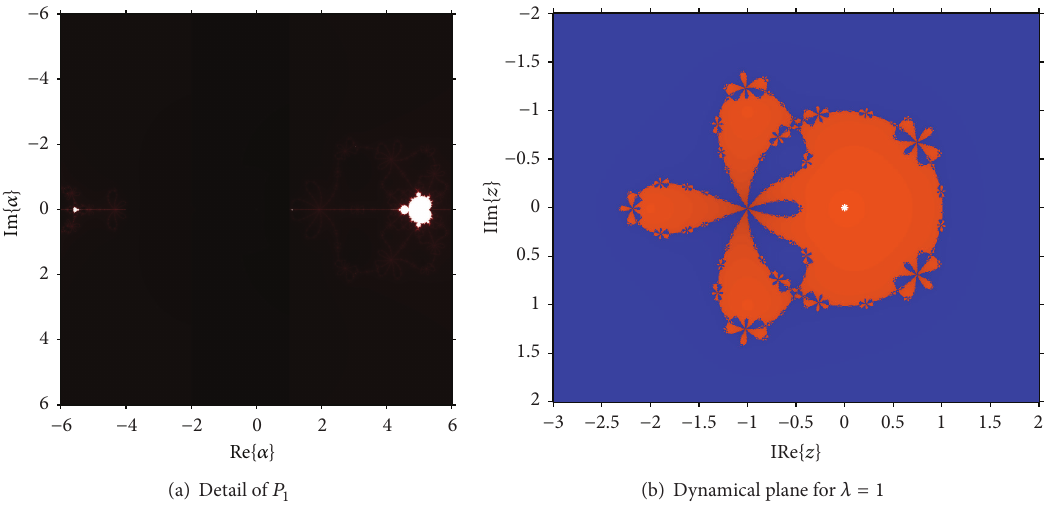
(b) Dynamical plane for 𝜆 = 1 Figure 3: Around the